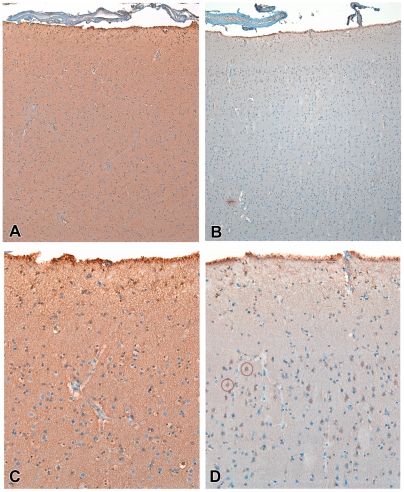
Immunohistochemical pattern of AChE in frontal cortex.(A) In controls there is diffuse and intense pattern of immunoreactivity involving mainly the neuropil. (B) In MDD subjects, though variable, immunostaining was reduced. Both 200×. (C) In controls, there is virtually no perikaryal staining. (D) The latter contrasts with the pattern observed in some areas in MDD subjects, in which groups of pyramidal neurons display intense perikaryal staining, suggesting redistribution of the enzyme to the cell body. The red circles highlight examples. Both 640×.